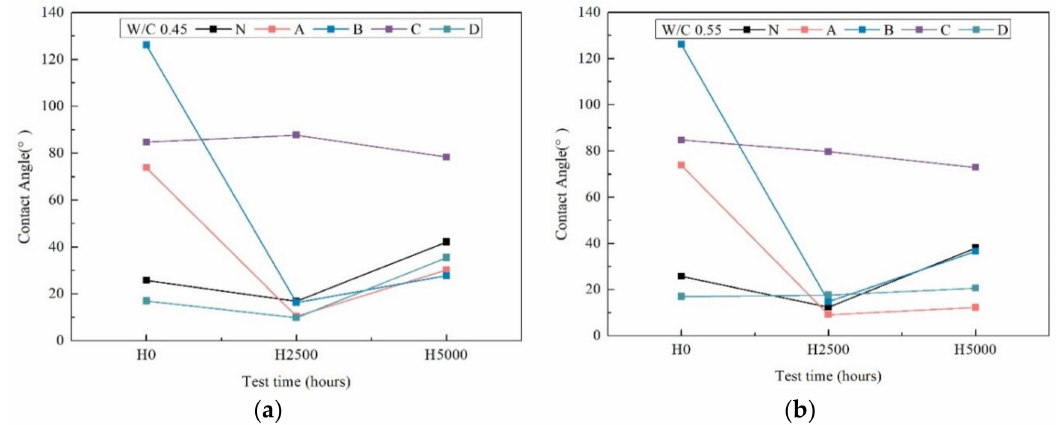
Figure 6. Contact angle test after 0 h, 2500 h and 5000 h weathering of w/c ratio 0.45 ( a ) and 0.55 ( b ).